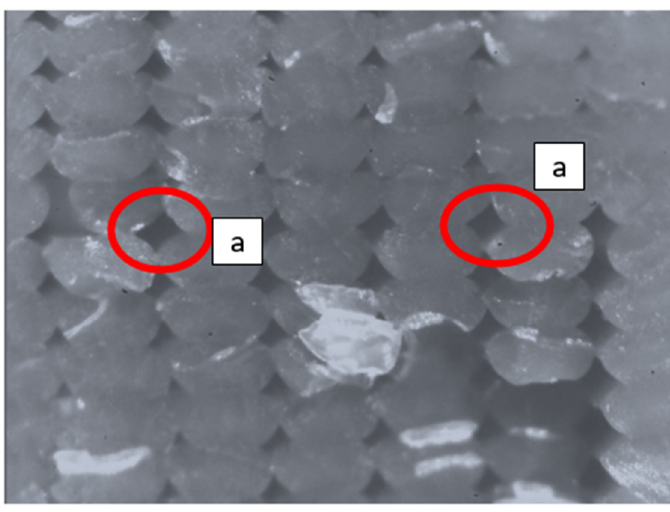
Figure 1. Defect appearance on a PLA specimen: ( a ) material voids between adjacent